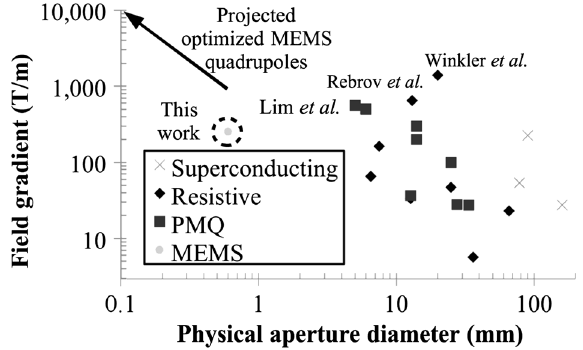
FIG. 2. Peak field gradient of superconducting and resistive electromagnet, permanent magnet (PMQ), and the MEMS quadrupoles described here. The tested MEMS quadrupole is circled and the simulated results for optimized quadrupole designs are indicated by the